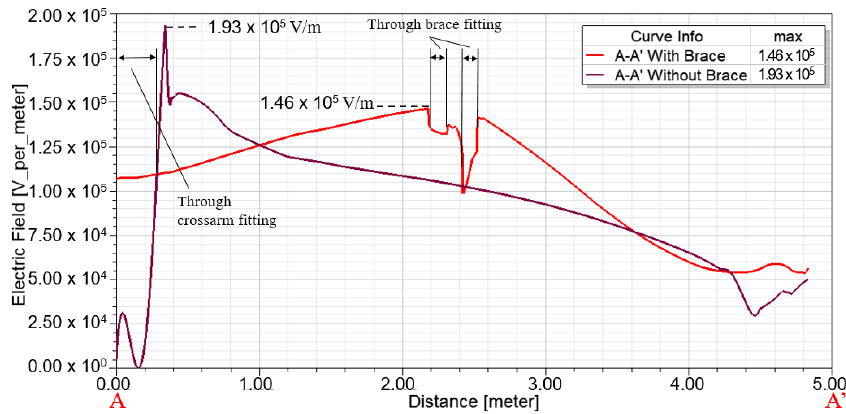
Figure 16. E-Field profiles along the main member (A –A’ ).